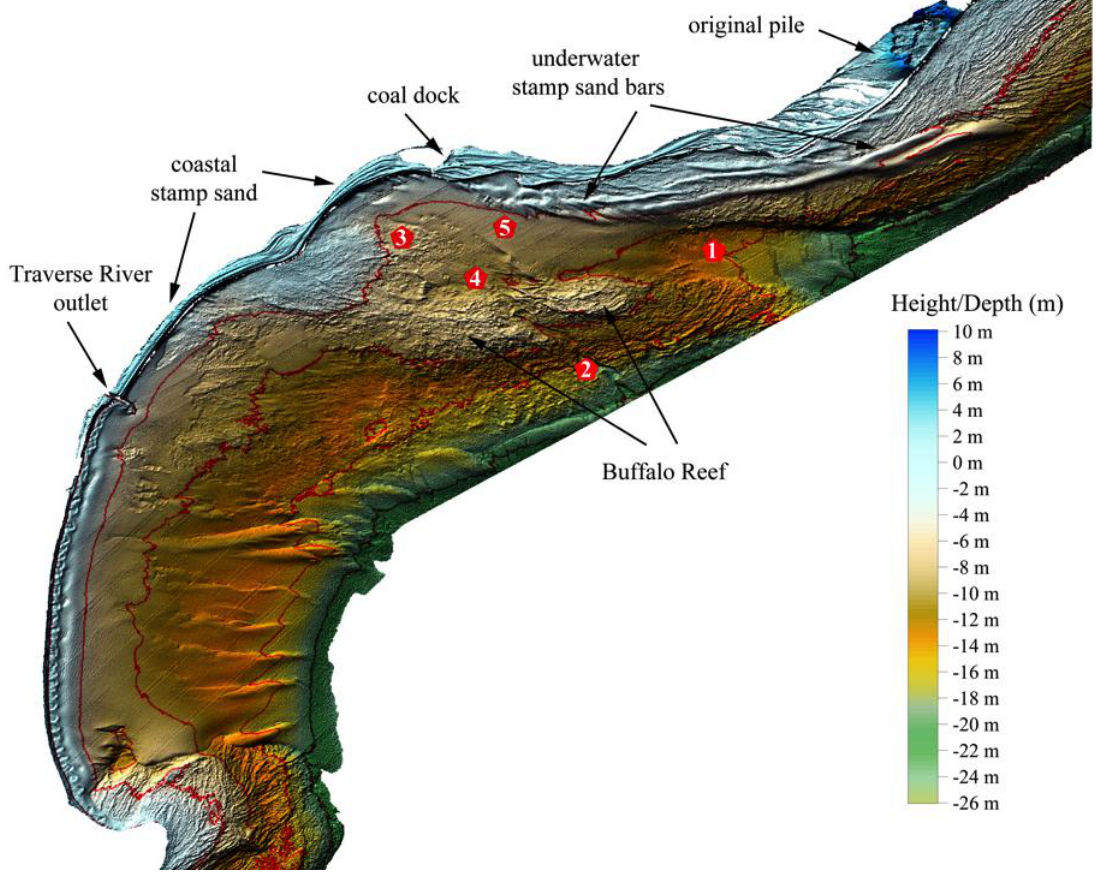
Figure 5. 2010 LiDAR-derived bathymetry of Grand Traverse Bay, showing the positions of the original Gay tailings pile, above-water (deep blue region) stamp sands along the beach stretch from the pile to the Coal Dock and southwestward to the Traverse River seawall and the central Buffalo Reef area. The “trough” region, an old riverbed, is in the center. To the northeast, note the underwater stamp sand bars moving across bedrock (Jacobsville Sandstone) to deposit in the “trough”. To the southwest, natural sands and silts move out of the bay across the bottom into Lake Superior. Red horizontal contour lines are at 5-m depth intervals. ROV and side-scan sonar sites (1–5) are indicated in